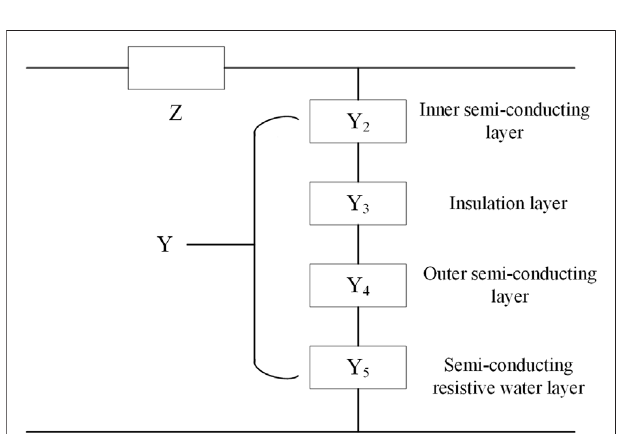
FIGURE 2 | 110 kV cable uniform transmission line